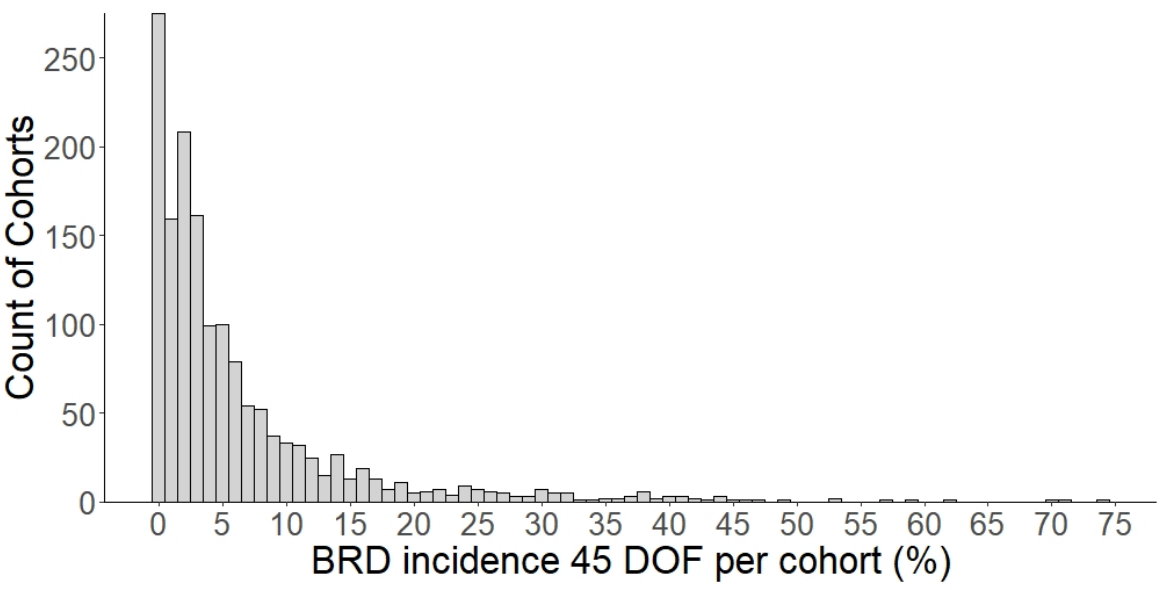
Figure 1. Histogram of the distribution of the level of BRD incidence in the first 45 days on feed (DOF) in the study population. The x -axis displays the percentage of BRD incidence in a cohort during the first 45 DOF. The y -axis displays the count of cohorts (pens) from 10 United States feedlots for each value.